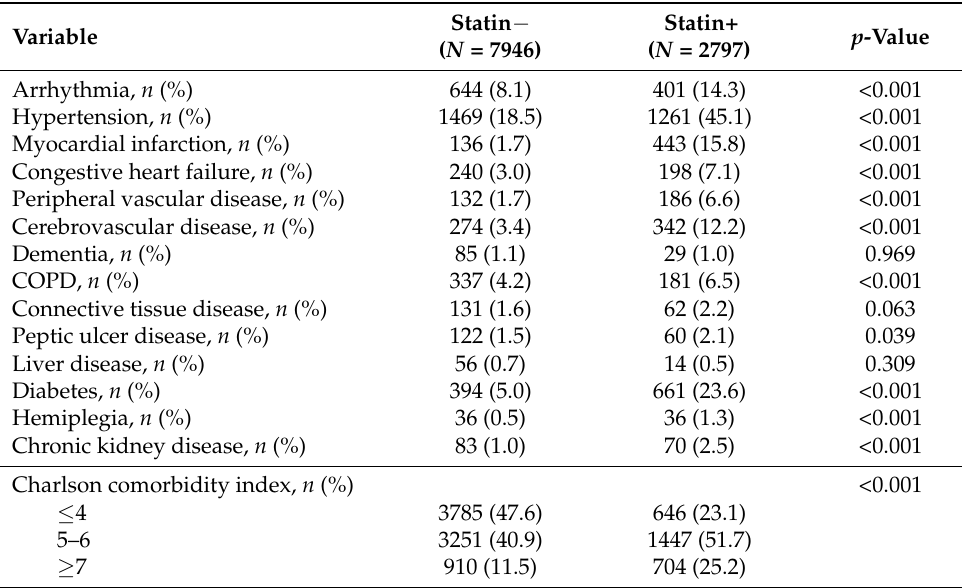
Table 2. Patient comorbidities as recorded on the day of